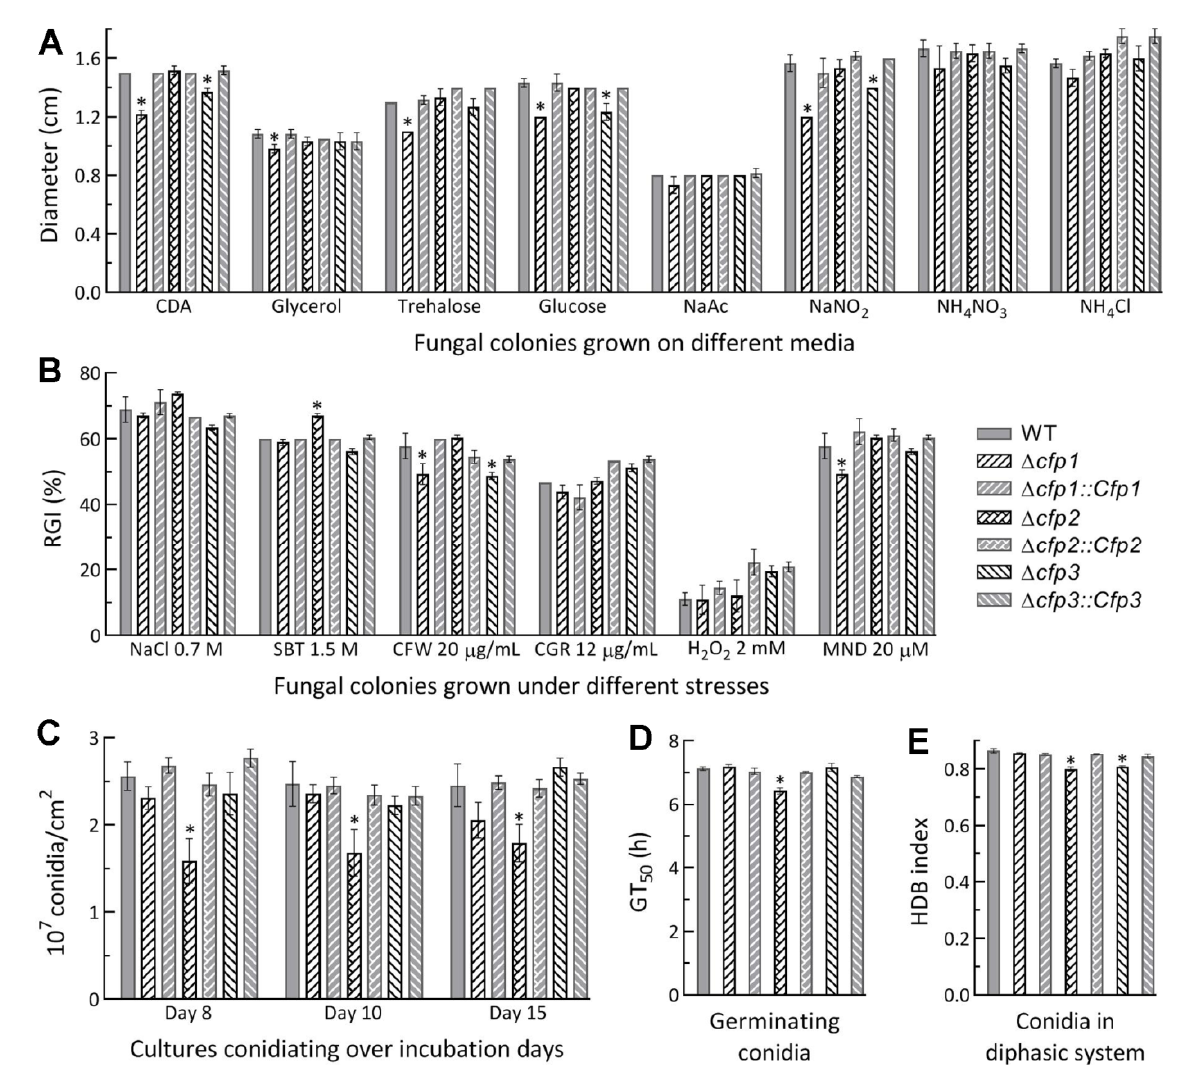
Figure 2. Limited roles of cfp1–3 in the asexual cycle in vitro of M. robertsii . ( A ) Diameters of fungal colonies grown at the optimal regime of 25 °C and L:D 12:12 for 7 d on minimal medium CDA and CDAs amended with different carbon or nitrogen sources. ( B ) Relative growth inhibition (RGI) percentages of fungal colonies grown at 25 °C for 7 d on CDA plates supplemented with indicated concentrations of stress agents (SBT, sorbitol; CFW, calcofluor white; CGR, Congo red and MND, menadione). All colonies were initiated by spotting 1 μ L aliquots of a 10 6 conidia/mL suspension. ( C ) Conidial yields measured from the cultures during a 15 ‐ d incubation on 1/4 SDAY plates at the optimal regime after initiation of each culture by spreading 100 μ L of a 10 7 conidia/mL suspension per plate. ( D ) GT 50 for 50% germination of conidia at 25 °C. ( E ) Indices of conidial hydrophobicity (HDB) assessed in a biphasic (aqueous ‐ organic) system. * p < 0.05 in Tukey’s HSD tests. Error bars: